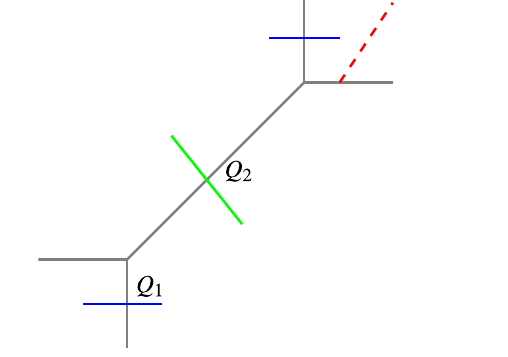
Fig. 4 Partially compactified toric diagram of resolved conifold with a Lagrangian